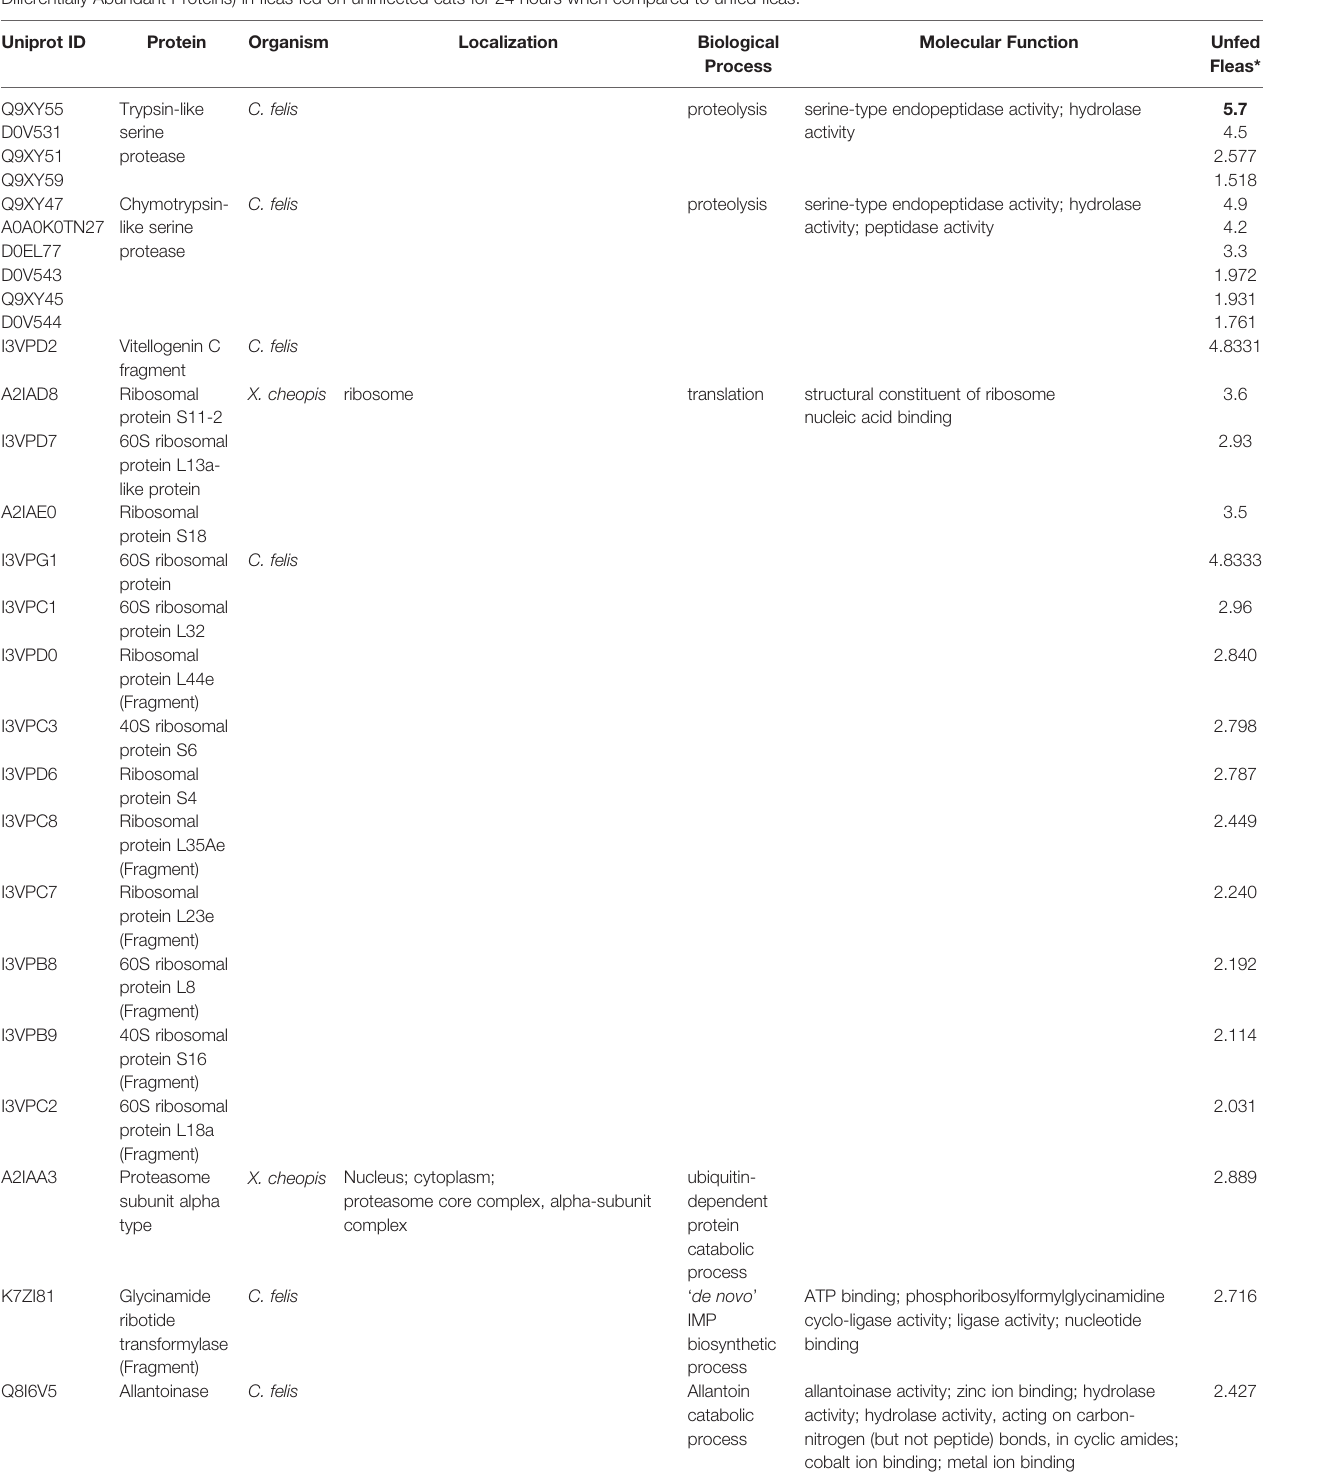
TABLE 2 | Uniprot identi fi cation number, associated protein, reference organism, cellular localization, biological process and molecular function of FDAP (Flea Differentially Abundant Proteins) in fl eas fed on uninfected cats for 24 hours when compared to unfed fl